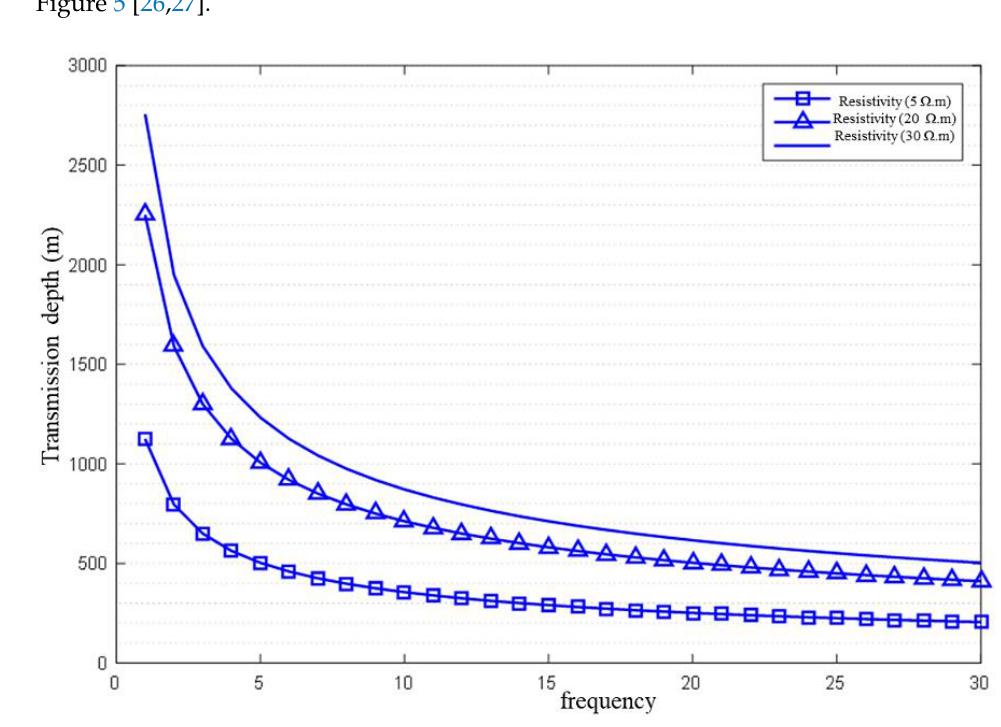
Figure 5. The relationship between the penetration depth, resistivity, and operating frequency.